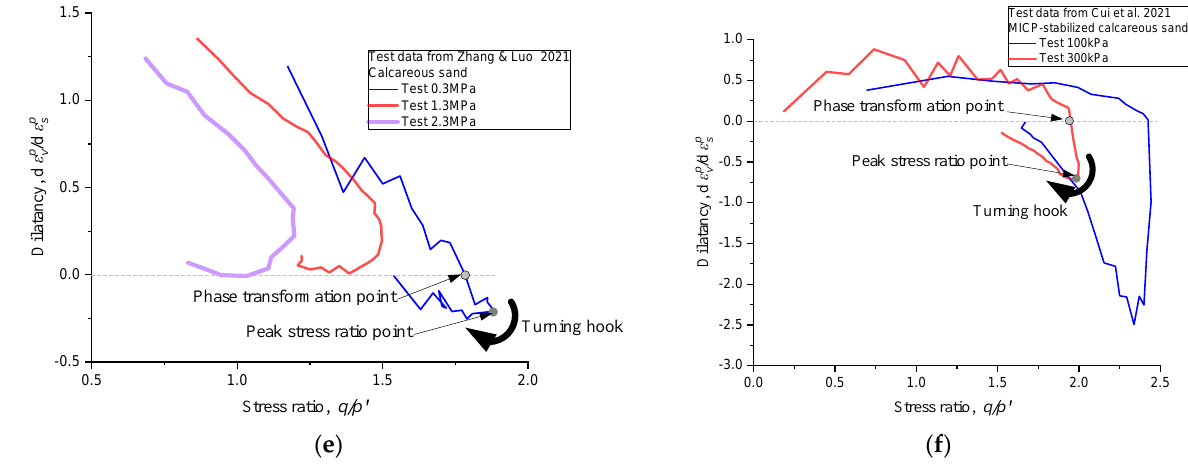
Figure 2. Turning hooks of stress − dilatancy curves of five crushable calcareous sands and one MICP-stabilized calcareous sand: ( a ) Wu et al., 2021 [1]; ( b ) Wang et al., 2022 [2]; ( c ) He et al., 2021 [3]; ( d ) Cui et al., 2021 [4]; ( e ) Zhang & Luo 2021 [5]; ( f ) Cui et al., 2021 [4].